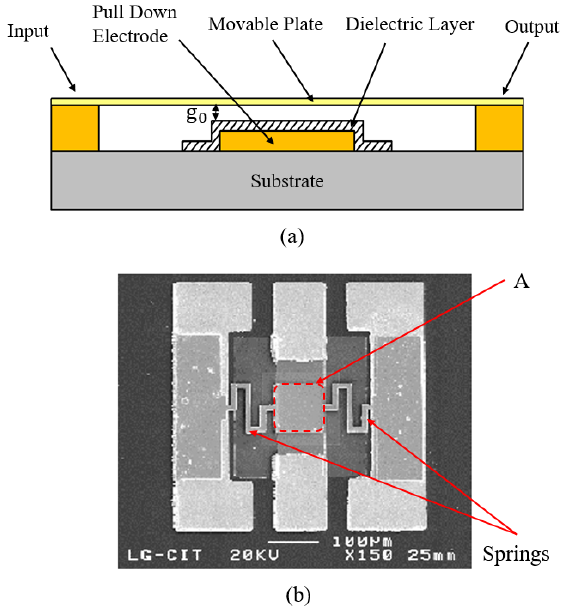
Figure 5. ( a ) The schematic of electrostatic capacitive MEMS switches; ( b ) The SEM image of a radio frequency (RF) MEMS capacitive switch fabricated by J.Y.Park et al. (2001 [10]).